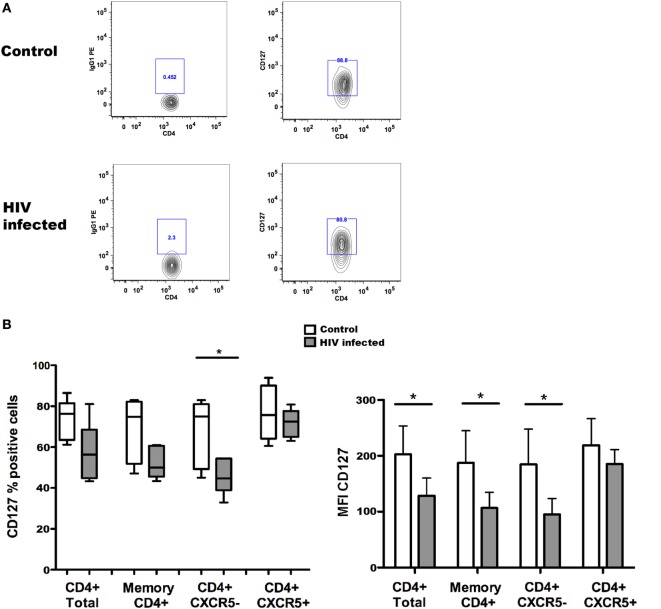
CD127 expression on memory T follicular helper (Tfh) cells from controls and HIV-1-infected individuals. The frequency of CD127+ cells [(B) left] and CD127 mean fluorescence intensity (MFI) [(B) right] were determined among total CD4+ and memory CD4+ T cells and Tfh (CXCR5+) and non-Tfh (CXCR5−) cells from non-infected control subjects and HIV-1-infected patients receiving antiretroviral treatment (ART). Representative flow cytometry plots of CD127 expression in one control and one HIV-1-infected individual (A); the cells were gated on alive, CD4+CD45RO+CXCR5+ Tfh cells before evaluation of CD127 expression. Blood samples were obtained from six healthy donors and six HIV-1-infected patients receiving ART, characterized by undetectable viremia (<20 copies/ml) and a mean CD4+ T cell count of 588 ± 443 cells/μl. Peripheral blood mononuclear cells were isolated using Ficoll gradient centrifugation (Lymphoprep, Axis-Shield PoC As, Norway) and stored frozen until required. The following fluorochrome-conjugated anti-human antibodies were used to characterize T cell populations: V500 and PE-anti-CD4, FITC anti-CD45RO, PerCP-Cy5.5, and Alexa Fluor 647 anti-CXCR5 and PE anti-CD127 (BD Pharmingen, San Diego, CA, USA). Viable cells were detected using Near-IR-Live/Dead (ViViD) kit (Invitrogen, Carlsbad, CA, USA). Fluorescence intensities were measured with LSRII (BD, San Jose CA, USA), and data were analyzed using FlowJo version 8.8.7 (Tree Star Inc., Ashland, OR, USA). Memory CD4+ T cells (CD4+ and CD45RO+) were further gated into Tfh (CXCR5+) and non-Tfh (CXCR5−) cell subsets based on the CXCR5 expression. Data were tested for normal distribution by Kolmogorov–Smirnow test, and analyses were performed using non-parametric Mann–Whitney test when comparing values from HIV-1-infected patients with non-infected controls. Statistical analyses were performed using Prism (version 5.0a, GraphPad Software Inc., San Diego, CA, USA). Data are represented by box and Whisker plots (minimum to maximum values). *p < 0.05.